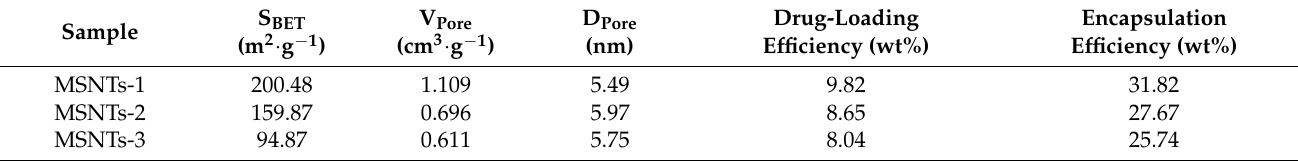
Table 1. Physico–chemical parameters and drug-loading efficiency of different